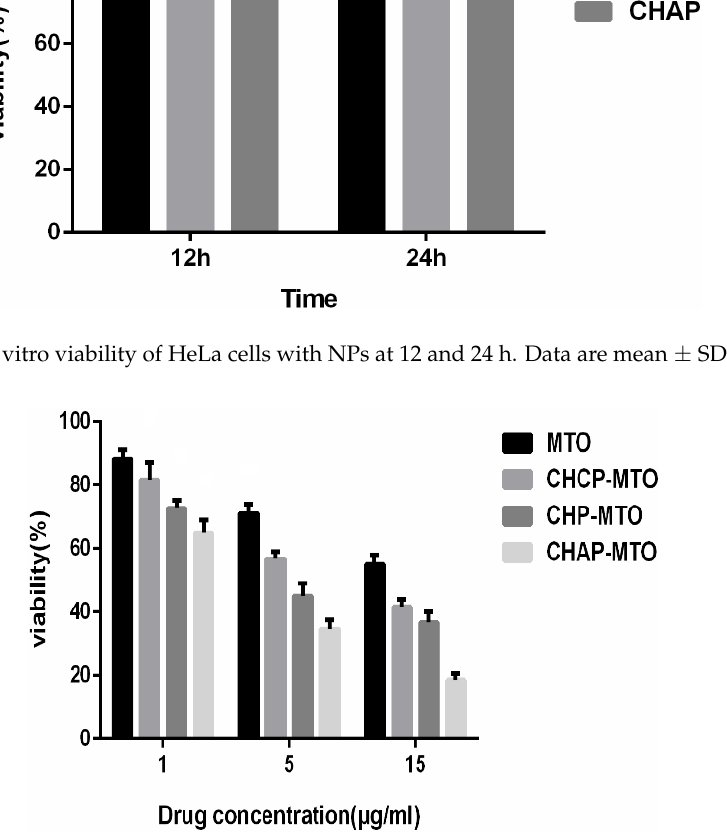
Figure 8. In vitro viability of HeLa cells with MTO alone and MTO-loaded NPs at 24 h. Data are mean ± SD ( n = 3).